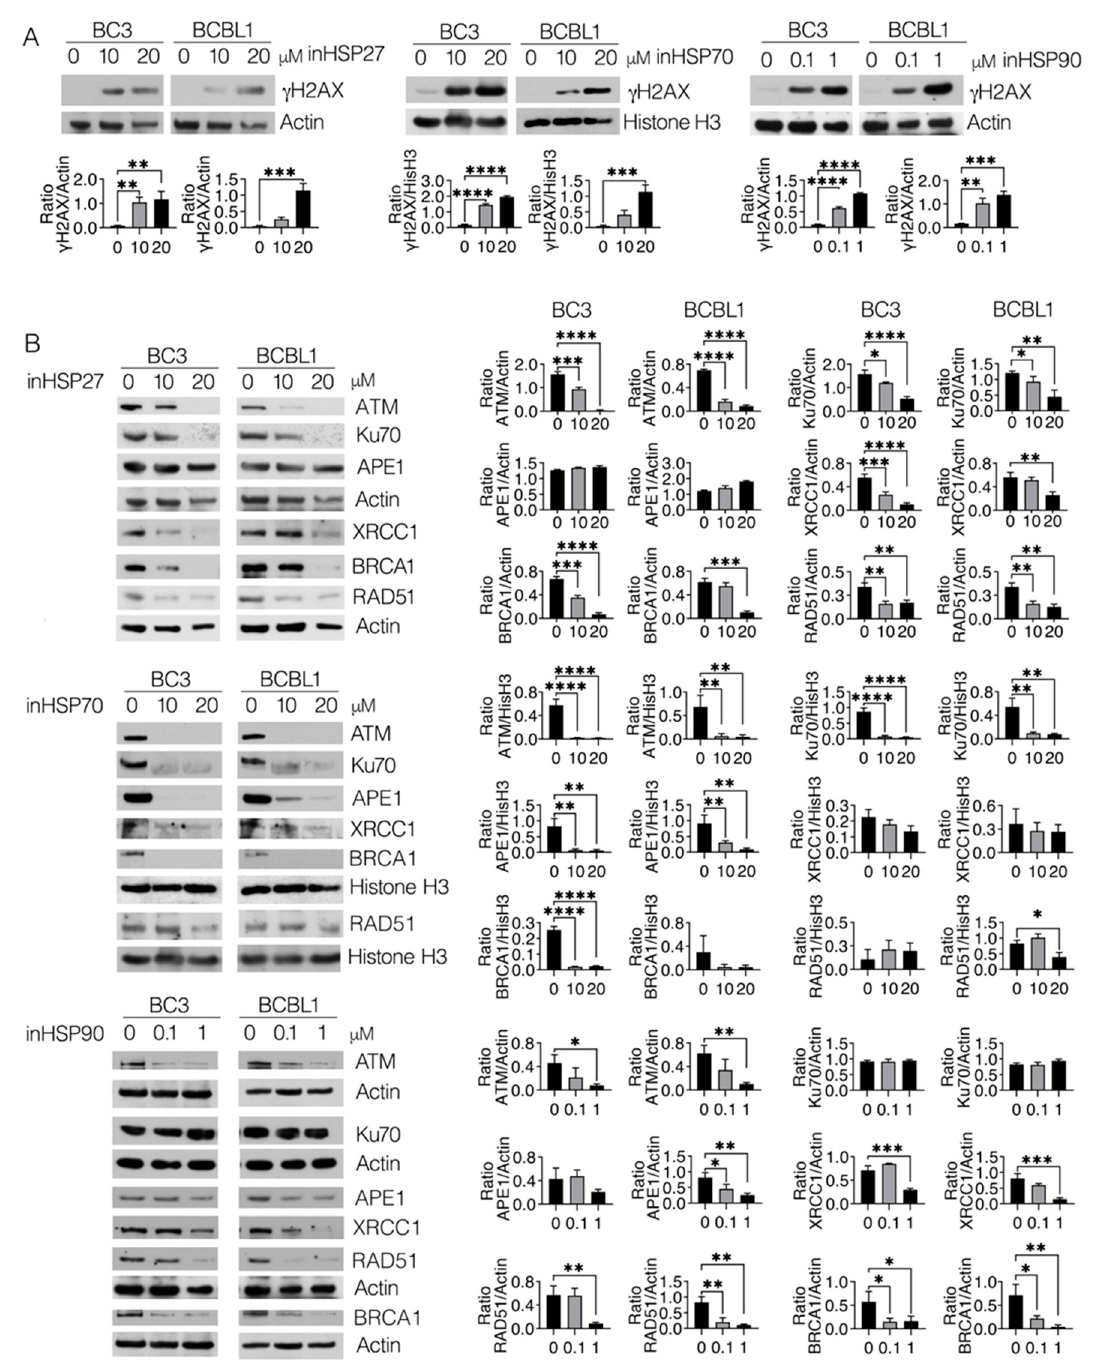
Figure 2. HSP inhibition induces DNA damage and DDR molecule downregulation in PEL cells. BC3 and BCBL1 cells were treated with inHSP27 (J2) (10–20 µM), inHSP70 (PES) (10–20 µM) or inHSP90 (17AAG) (0.1–1 µM) for 24 h and ( A ) protein expression levels of γ H2AX were evaluated by Western blot analysis. Actin or histone H3 was used as a loading control and one representative experiment is shown. The histograms represent the densitometric analysis of the ratio of γ H2AX/actin or histone H3. Data are represented as the mean plus S.D. p value: ** <0.01; *** <0.001; **** <0.0001. ( B ) Protein expression levels of ATM, Ku70, APE1, XRCC1, BRCA1 and RAD51 were evaluated by Western blot analysis. Actin or histone H3 was used as a loading control and one representative experiment is shown. The histograms represent the densitometric analysis of the ratio of specific protein/actin or histone H3. Data are represented as the mean plus S.D. p value: * <0.05; ** <0.01; *** <0.001; **** <0.0001.